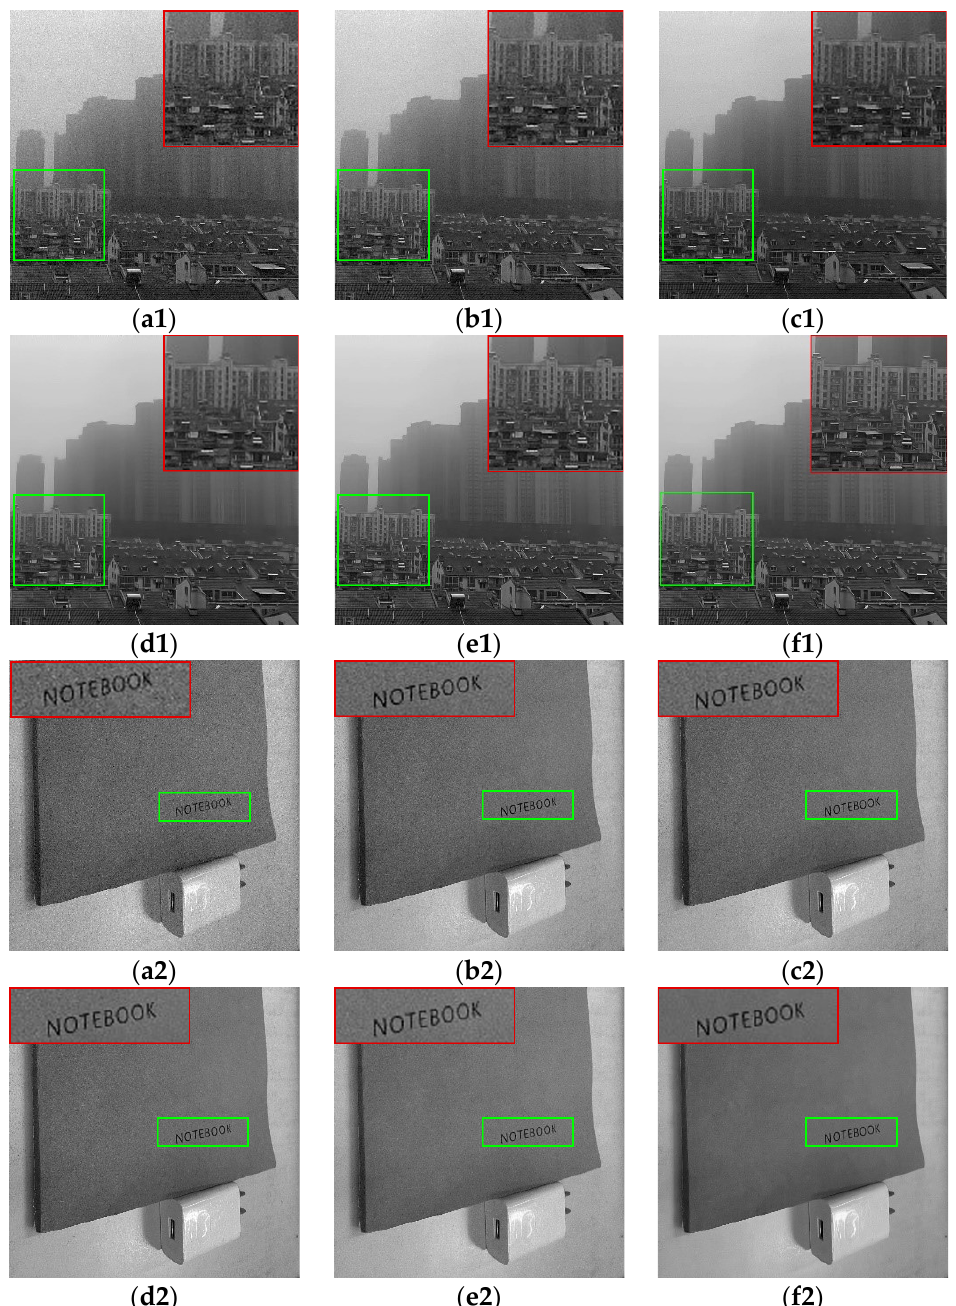
Figure 11. Image denoising comparison in real scenes. ( a1 , a2 ) The original image. ( b1 , b2 ) KPN [3].